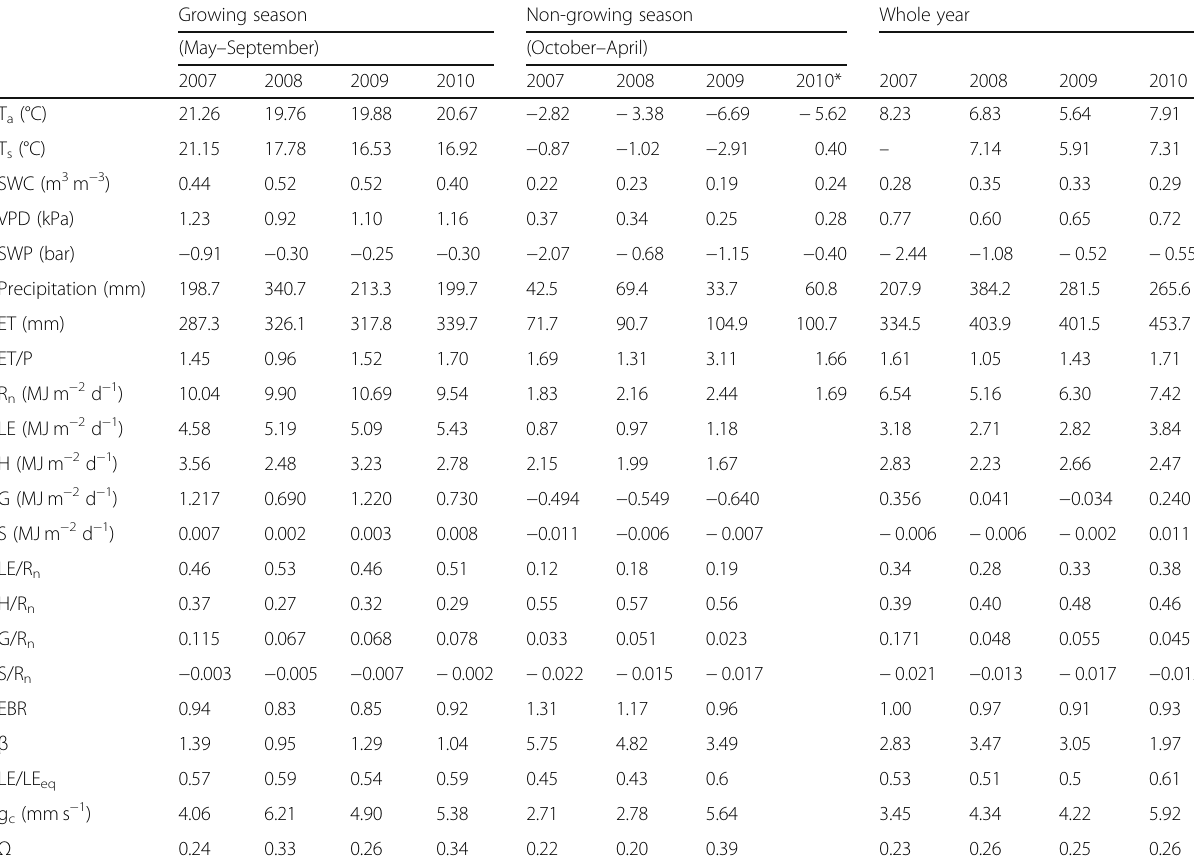
Table 1 Daily means of microclimatic variables and energy balance components during the growing season and non-growing season of 2007 – 2010 in Songnen meadow